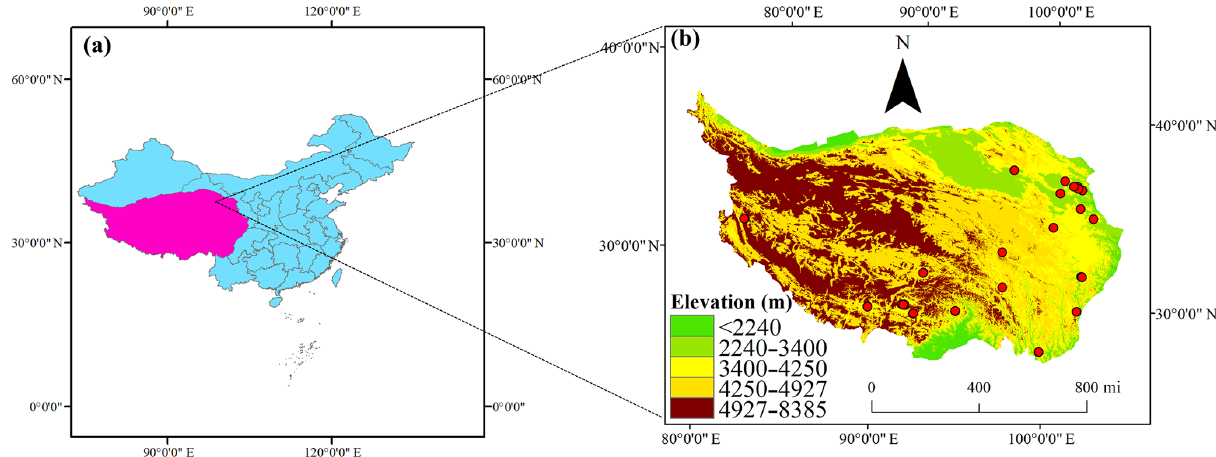
Figure 1. The geographical locations and annual mean 8h O 3 concentrations in the ground-observed sites (red dots) over the Tibetan Plateau during 2014–2018. The elevation data are collected from geographical and spatial data cloud at a 30m spatial